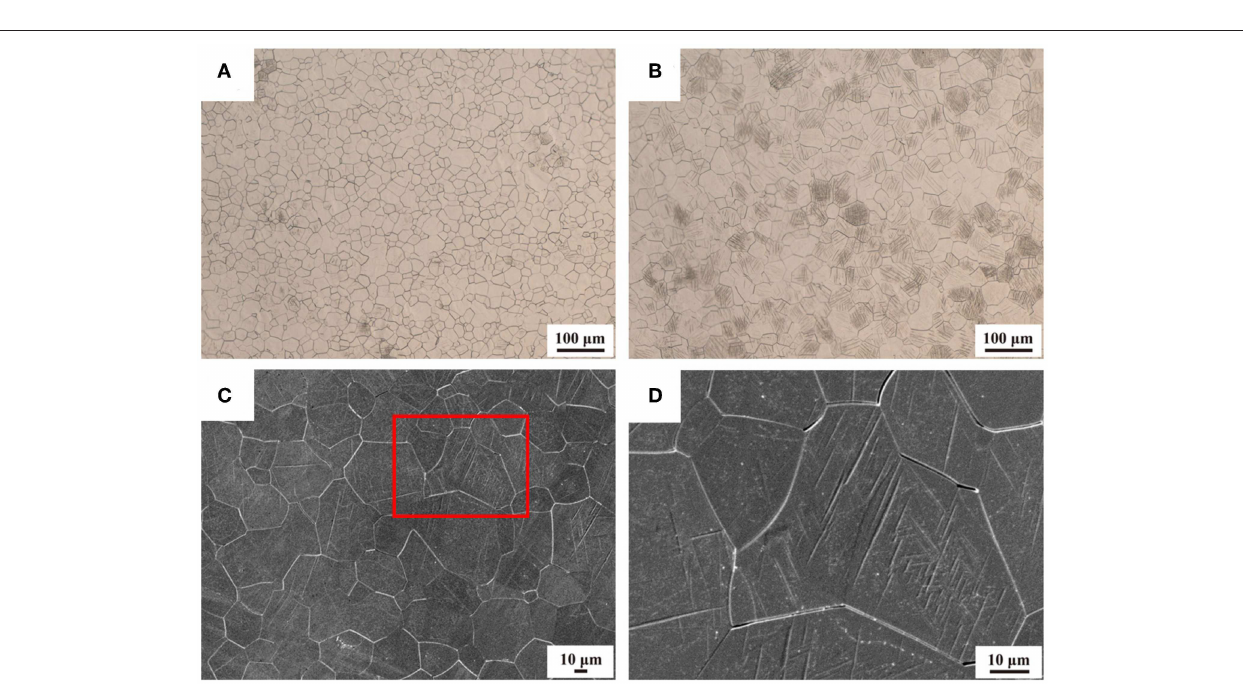
FIGURE 2 | Microstructure of Ti-35Nb-2Ta-3Zr alloy: (A) optical micrograph of the base metal, (B) optical micrograph of the laser-quenched alloy, (C) SEM of the laser-quenched alloy, (D) magnified SEM image of the rectangle in (C)